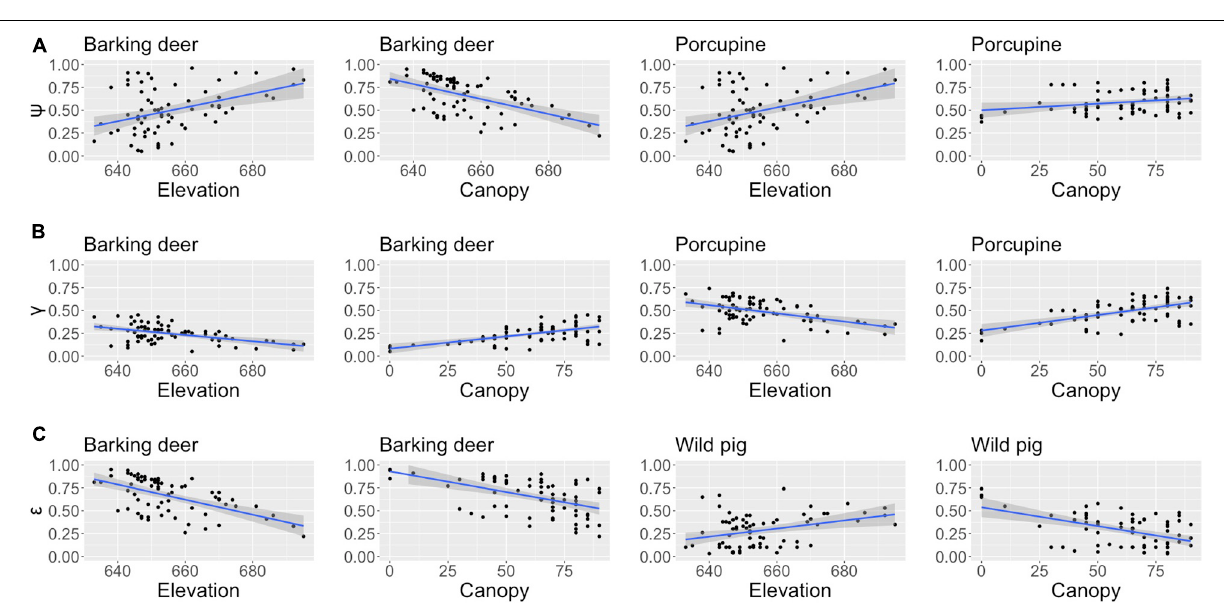
FIGURE 5 | Factors affecting species (A) occupancy, (B) colonization, and (C) extinction probabilities of common mammal species. The number of trees also showed statistically significant relationships to these probabilities, similar to those of canopy openness shown here ( Supplementary Tables 4–6